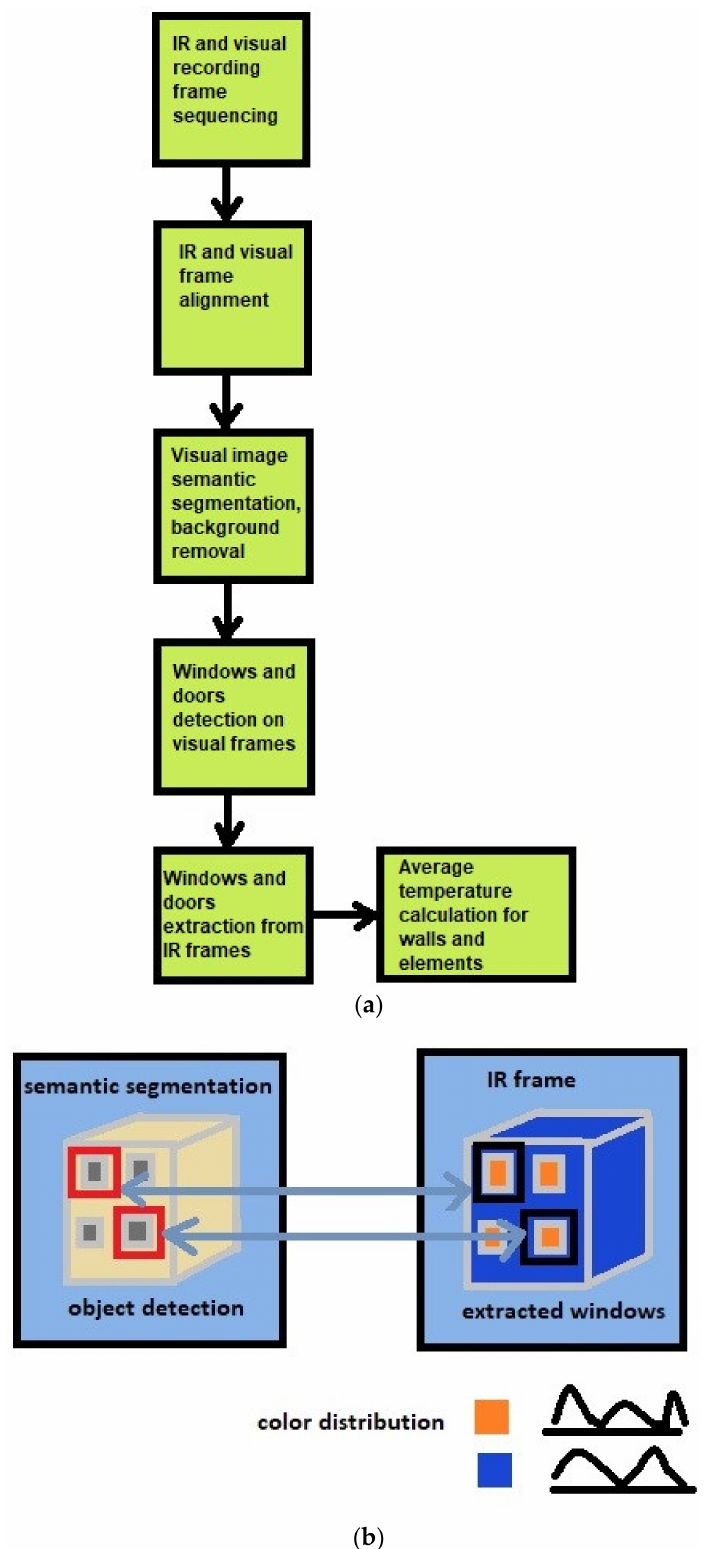
Figure 1. ( a ) Algorithm principle for parallel optical and IR frame processing; ( b ) schema. The assessment data on the energy efficiency of multiple objects were collected in February 2022. The equipment attributes are displayed in Table 1. As recommended for the IR survey, the temperature difference between the inside and the outside was at least 10 ◦